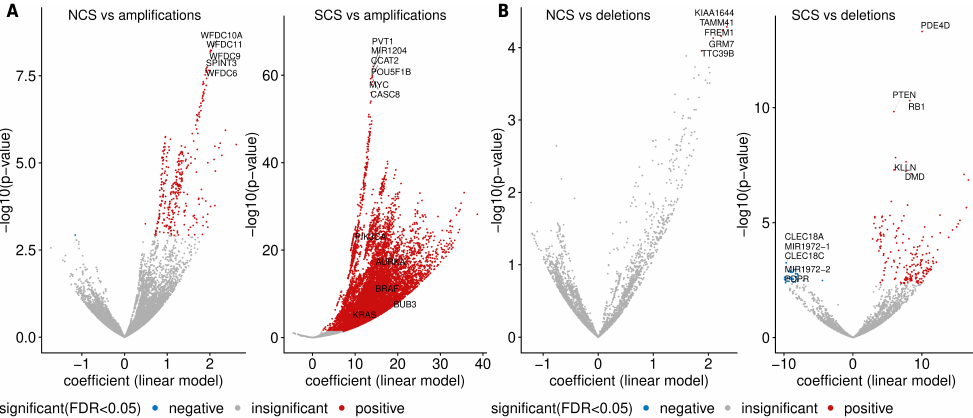
Figure 5. Copy number amplifications and deletions enriched in high-CIN samples. ( A ) The volcano plots show the gene-wise associations between copy number amplification status and NCS (left) and SCS (right), obtained from a regression model adjusted by cancer type. The linear model coefficient indicates the mean difference in the respective CIN score when the alteration is present in a tumour sample relative to the wild type. Genes with the lowest p-values and well-known CIN genes are highlighted. Blue and red colours encode genes with a significantly higher alteration frequency (FDR < 5%) in samples with low and high CIN scores, respectively. The analysis was performed on 16,922 genes with sample sizes greater than 19 for both wild type and amplified groups. ( B ) Pan-cancer copy number deletions associated with SCS are displayed in an analogous way to ( A